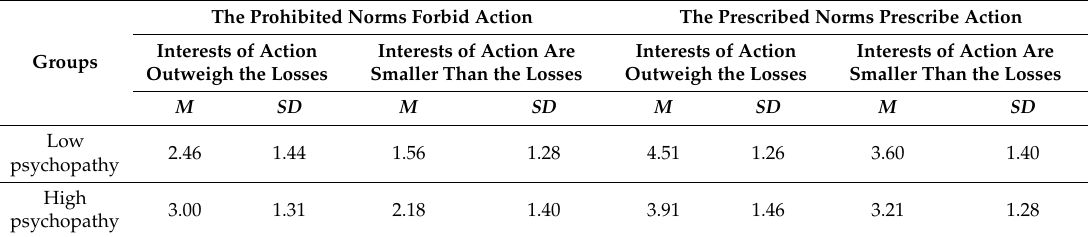
Table 2. The mean value and 95% confidence interval for the responses to moral dilemmas of action (as opposed to inaction) that include prohibited and prescribed norms and consequences in which the interests of the action are outweighed or less than the losses of